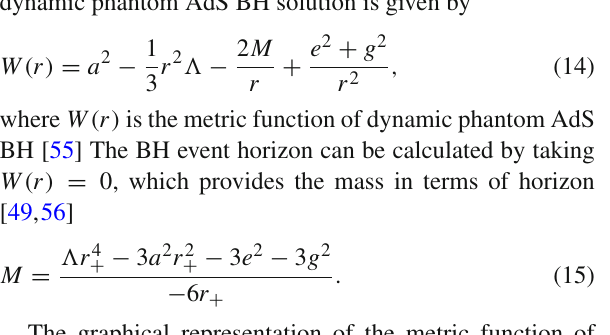
Fig. 1 The metric function W ( r ) for distinct values of (cid:7) and e at fixed g = 0 . 6 and M = 1. Left Panel: a 2 = 1 and right panel: a 2 =